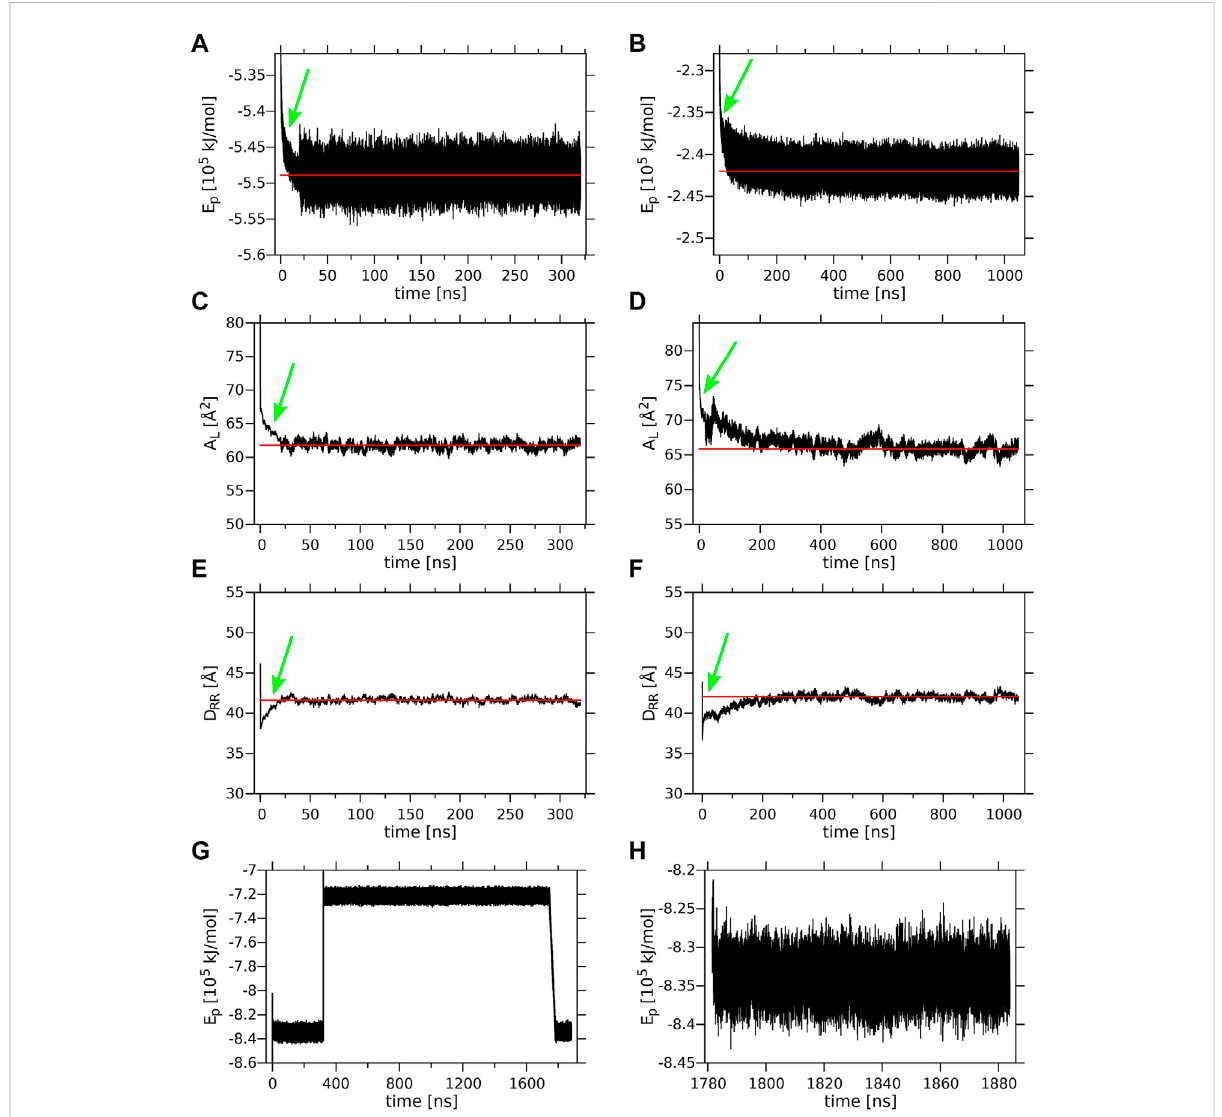
FIGURE 3 EquilibrationofthelamellarMGDG andDGDG bilayers andtheW15system. Time pro fi lesofthe (A) MGDG and (B) DGDGpotential energy(Ep); (C) MGDG and (D) DGDG average surface area per lipid (A L ); (E) MGDG and (F) DGDG average bilayer width (D RR ), during 320 and 1,050 ns, respectively,ofMDsimulationsat295 K. (A – F) Thetime(20 ns)whenthe T and p controlmethodswereswitched(cf.sec.2.2)ismarkedwitha green arrow; the red line shows the average value of a given parameter. Time pro fi les of Ep (G) for the whole ~1,800-ns and (H) for the last 100-ns (when the system ’ s temperature was 295 K) of MD simulation of the W15